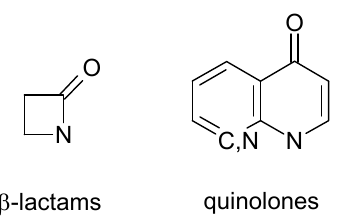
Figure 4. Main classes of antibiotics under